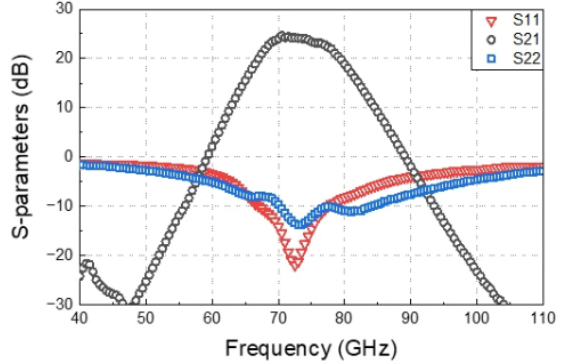
Figure 10. Measured S-parameters of the VGA.